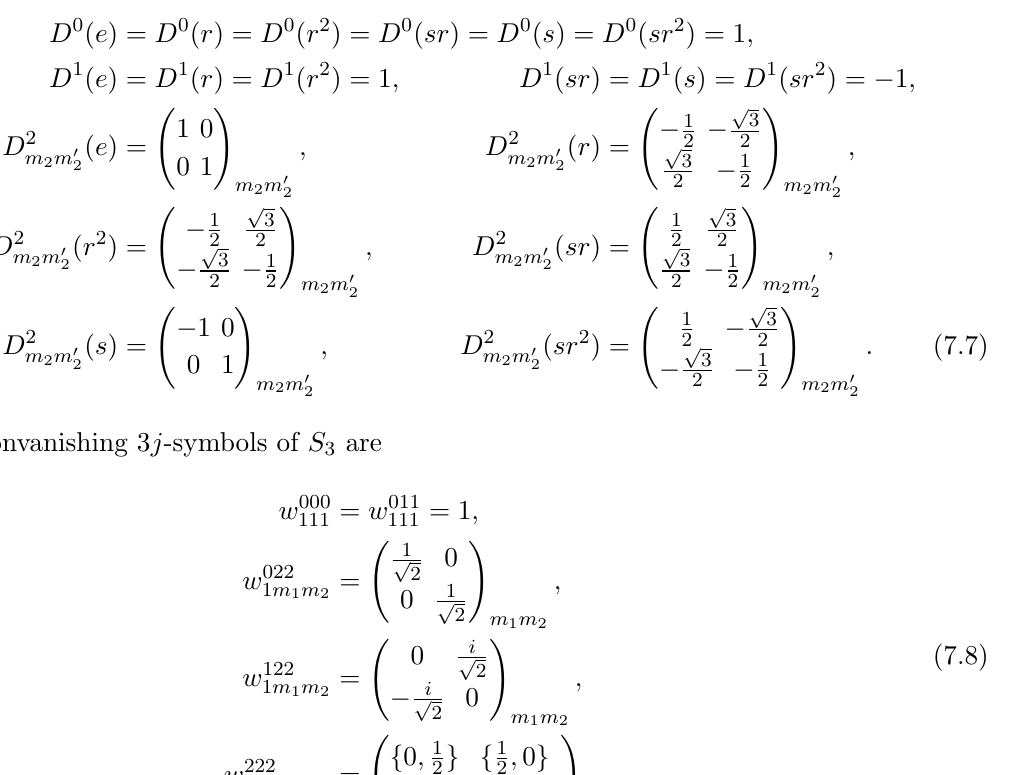
irreducible representations matrices is listed as